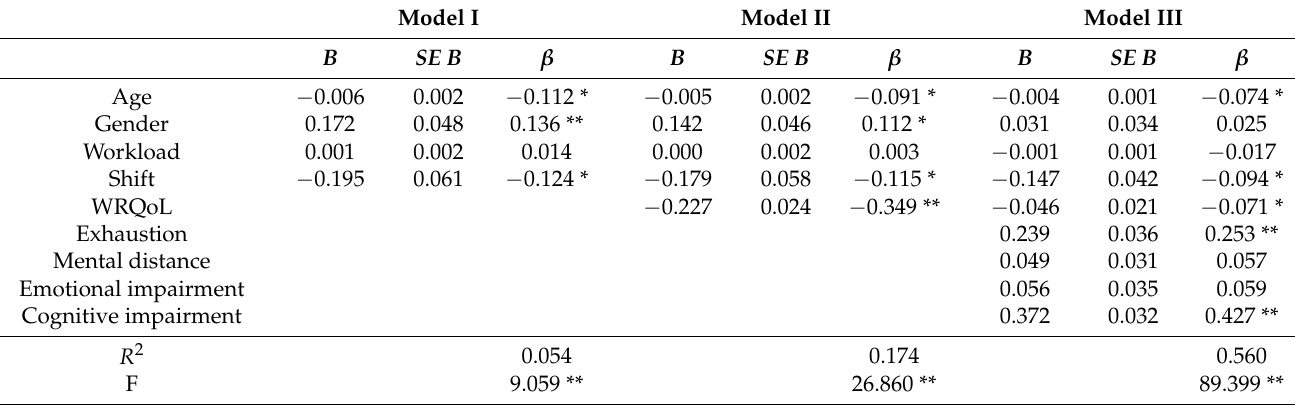
Table 5. Hierarchical multiple regression analysis predicting overall Mental Health